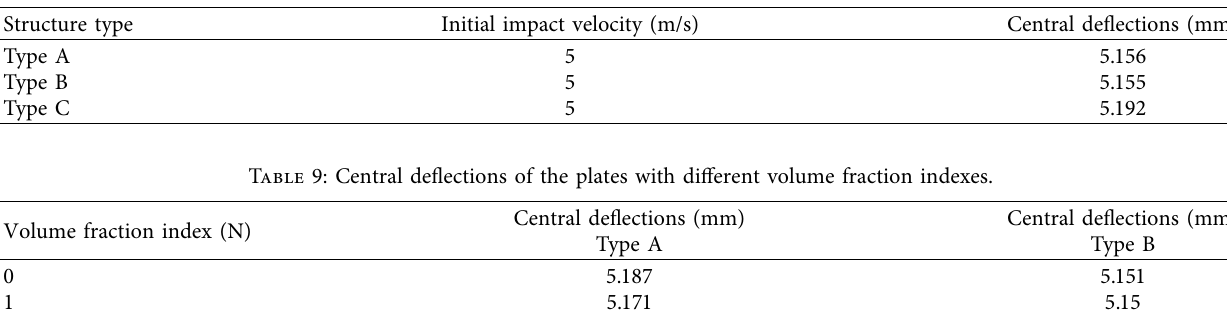
Figure 11: Energy absorption capacity with different initial impact velocities. (a) Type A. (b) Type B. Table 8: Central deflections of three plates under same impact velocity.